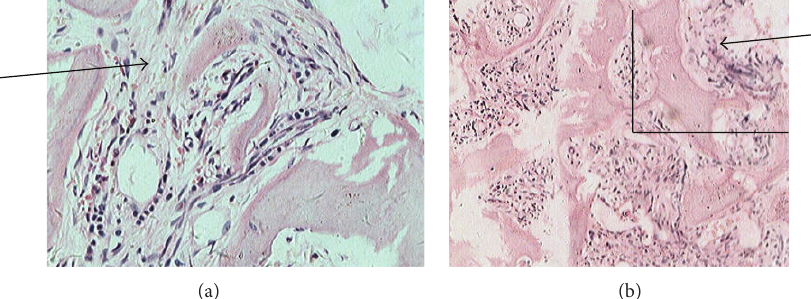
Figure 4: Iliac bone marrow biopsy shows increased fibroblasts and reduced marrow cellularity with an increase in reticulin (100 and 200x). On November 18, 2009, an iliac bone marrow biopsy was performed in the patient, and the slide was stained with H&E. The arrows show increased fibrous tissue. The upper panel (200x) is a blowup of the panel (100x) within the square area.